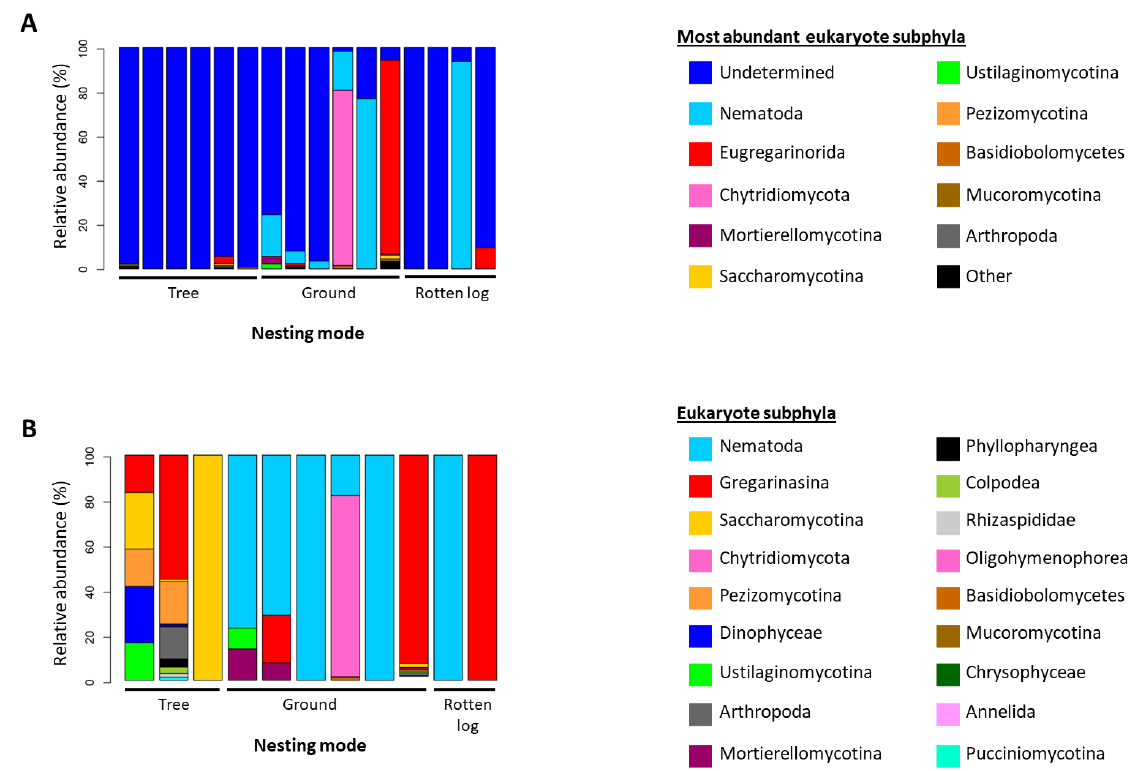
Figure 6. ( A ) Taxa bar plot based on the relative abundance ordered by ant nesting mode with all ASVs. The relative abundance bars are colored by the percentages of eukaryote subphyla. The 11 most abundant eukaryote subphyla associated with Amazonian ants are listed. The less abundant eukaryote subphyla are grouped under the term “Other”. The term “Undetermined” represents eukaryote ASVs that could not be identified with the SILVA taxonomy. ( B ) Taxa bar plot based on the relative abundance ordered by ant nesting mode after removing all undetermined eukaryote ASVs. The relative abundance bars are colored by the percentages of eukaryote subphyla. A description of each eukaryote subphyla and examples of genera associated with each subphylum can be found in Supplementary File S11.